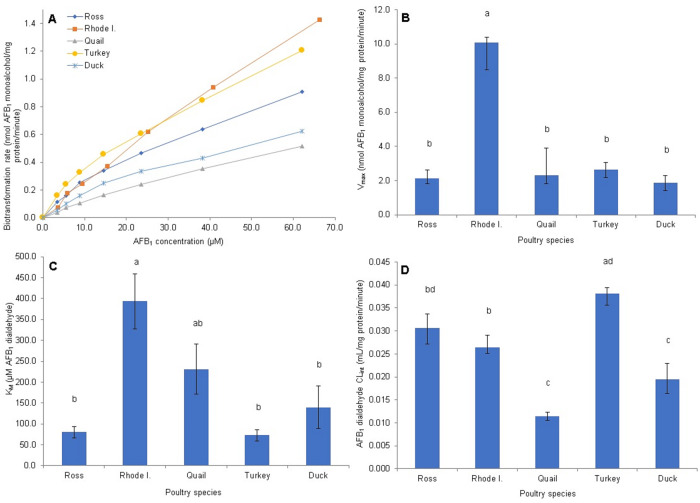
Enzyme kinetic parameters of cytosolic in vitro AFB1 monoalcohol production from AFB1 dialdehyde.(A) Saturation curve at AFB1 dialdehyde concentrations of 3.4 to 66.4 μM (B) Maximal velocity (Vmax). (C) Michaelis-Menten constant (Km). (D) Intrinsic Clearance (CLint; Vmax/Km). Species mean values sharing the same letter do not differ significantly. Statistical differences (P <0.05) were calculated using the Kruskal-Wallis test and nonparametric multiple comparisons were done by the Dwass-Steel-Critchlow-Fligner method. Values are means ± SEM of 12 birds.